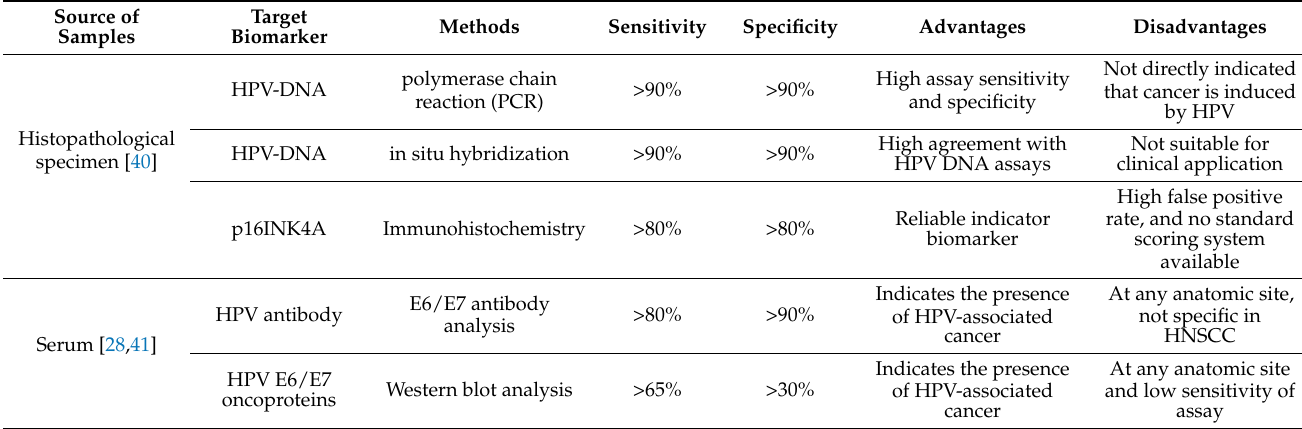
Table 3. Summarization of detection and diagnosis of HPV in oral